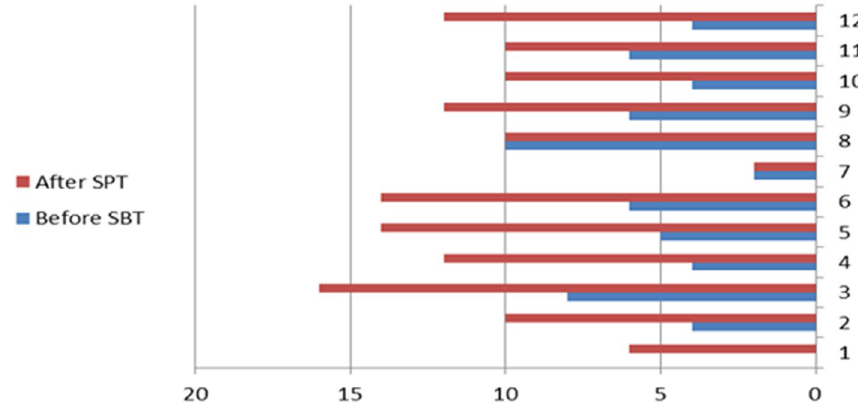
Fig. 2 The changes in number of B lines in patients with weaning‑induced pulmonary edema